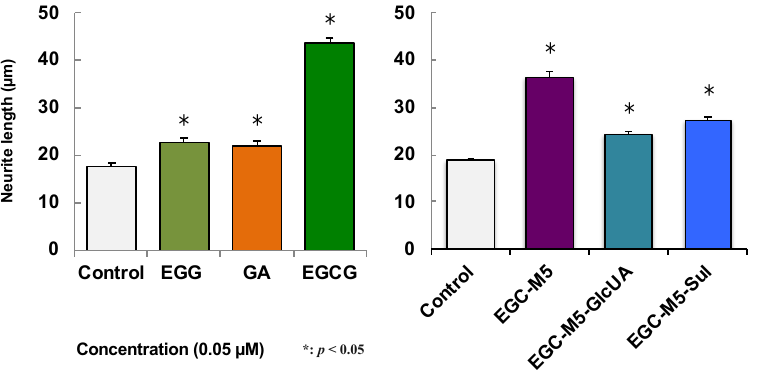
Figure 3. The neurite outgrowth of human SH-SY5Y cells treated with EGCG and its metabolites. A cell suspension (2.5 × 10 4 cells/well) was plated in a 24-well plate. Samples dissolved in 0.01% DMSO were added to the culture medium to produce a final concentration of 0.05 μM, and these were cultured for 72 h at 37 °C. Each value represents the mean ± SEM (neurite length, n = 103–107). Asterisks represent significant differences relative to the control (* p < 0.05, Bonferroni’s t -test) [17,48].